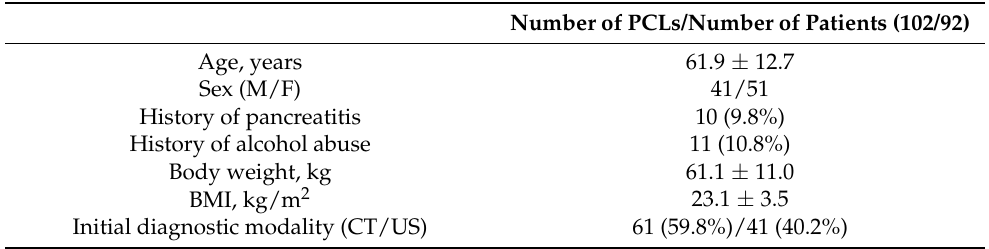
Table 1. Summary of patient demographics.